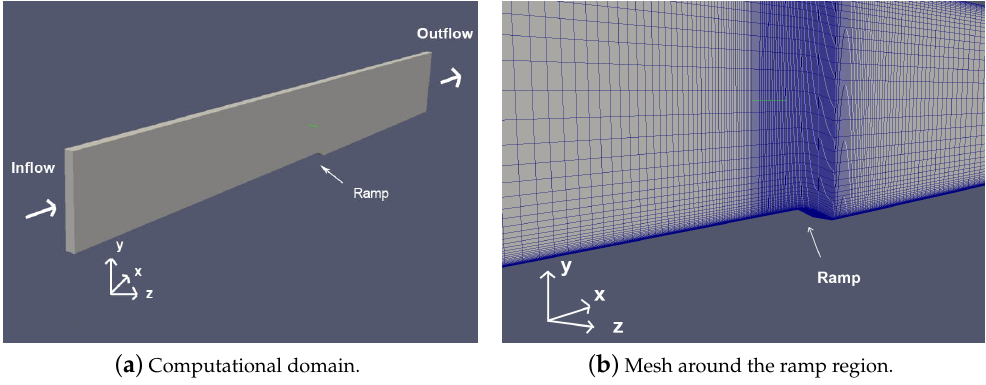
Figure 6. Computational domain and mesh detail of the VG positioned on the flat plate upstream the backward-facing